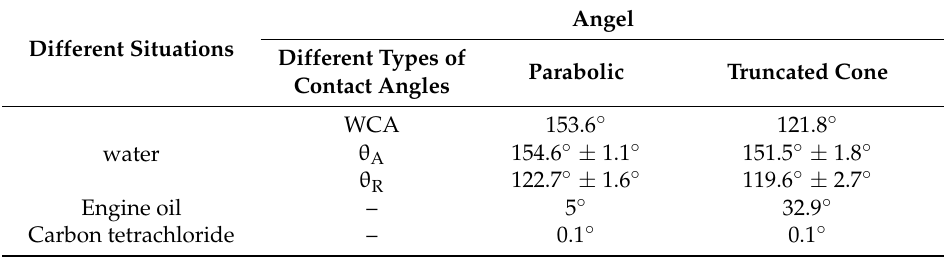
Table 1. Contact angles of different materials on different morphologies.